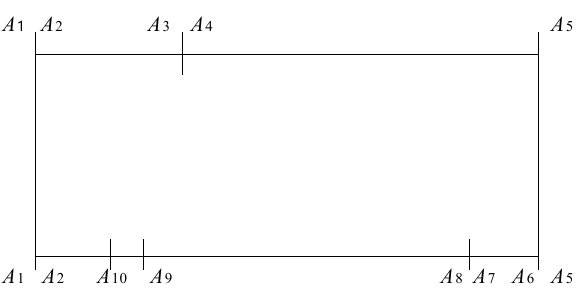
Figure 5. The structure and composition number of a used gearbox.